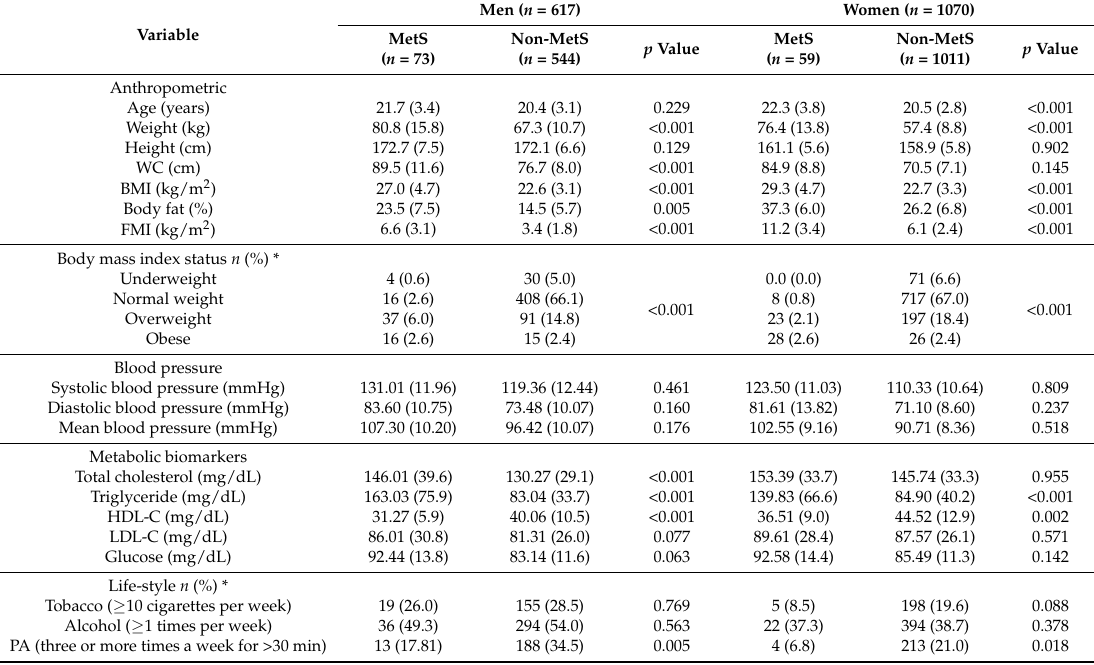
Table 2. The descriptive characteristics of participants with and without MetS in both sexes.